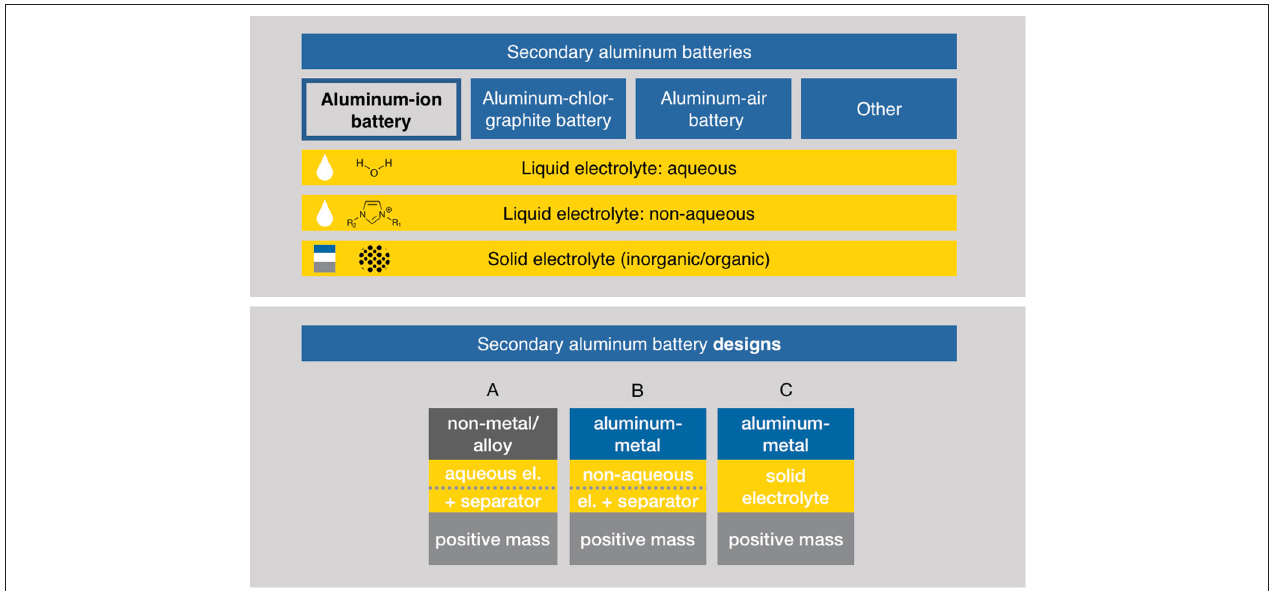
FIGURE 5 | Categorization of aluminum batteries in regard to their operating scheme and their used type of electrolyte. Other battery types are dual-ion batteries ( Zhao et al., 2018). Below, different conceivable secondary aluminum-ion battery designs are depicted. (A) This design does not make use of the full potential of aluminum since the negative electrode is either an alloy or a non-metal. The designs in (B,C) use aluminum metal as negative electrode, (B) uses a liquid and (C) a solid